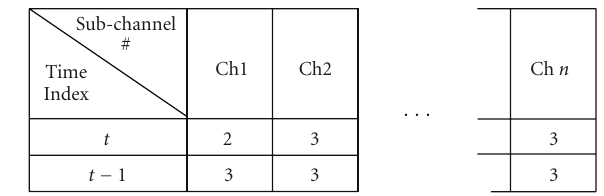
Figure 1: An example of the Bit Map.